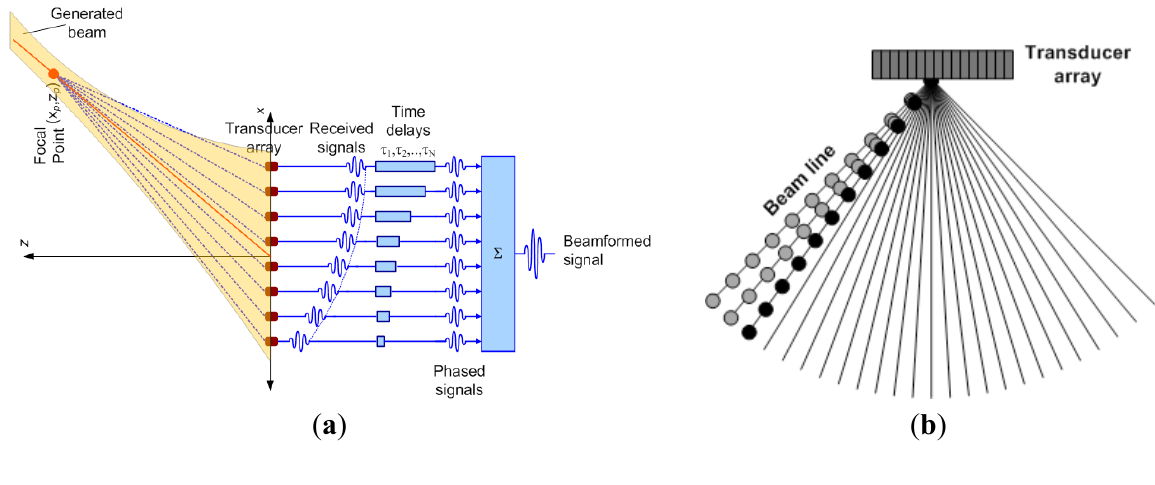
Figure 3. Scanning the interested area using transducer array. ( a ) Construction of a beamformed signal; ( b ) Scanning by constructing successive